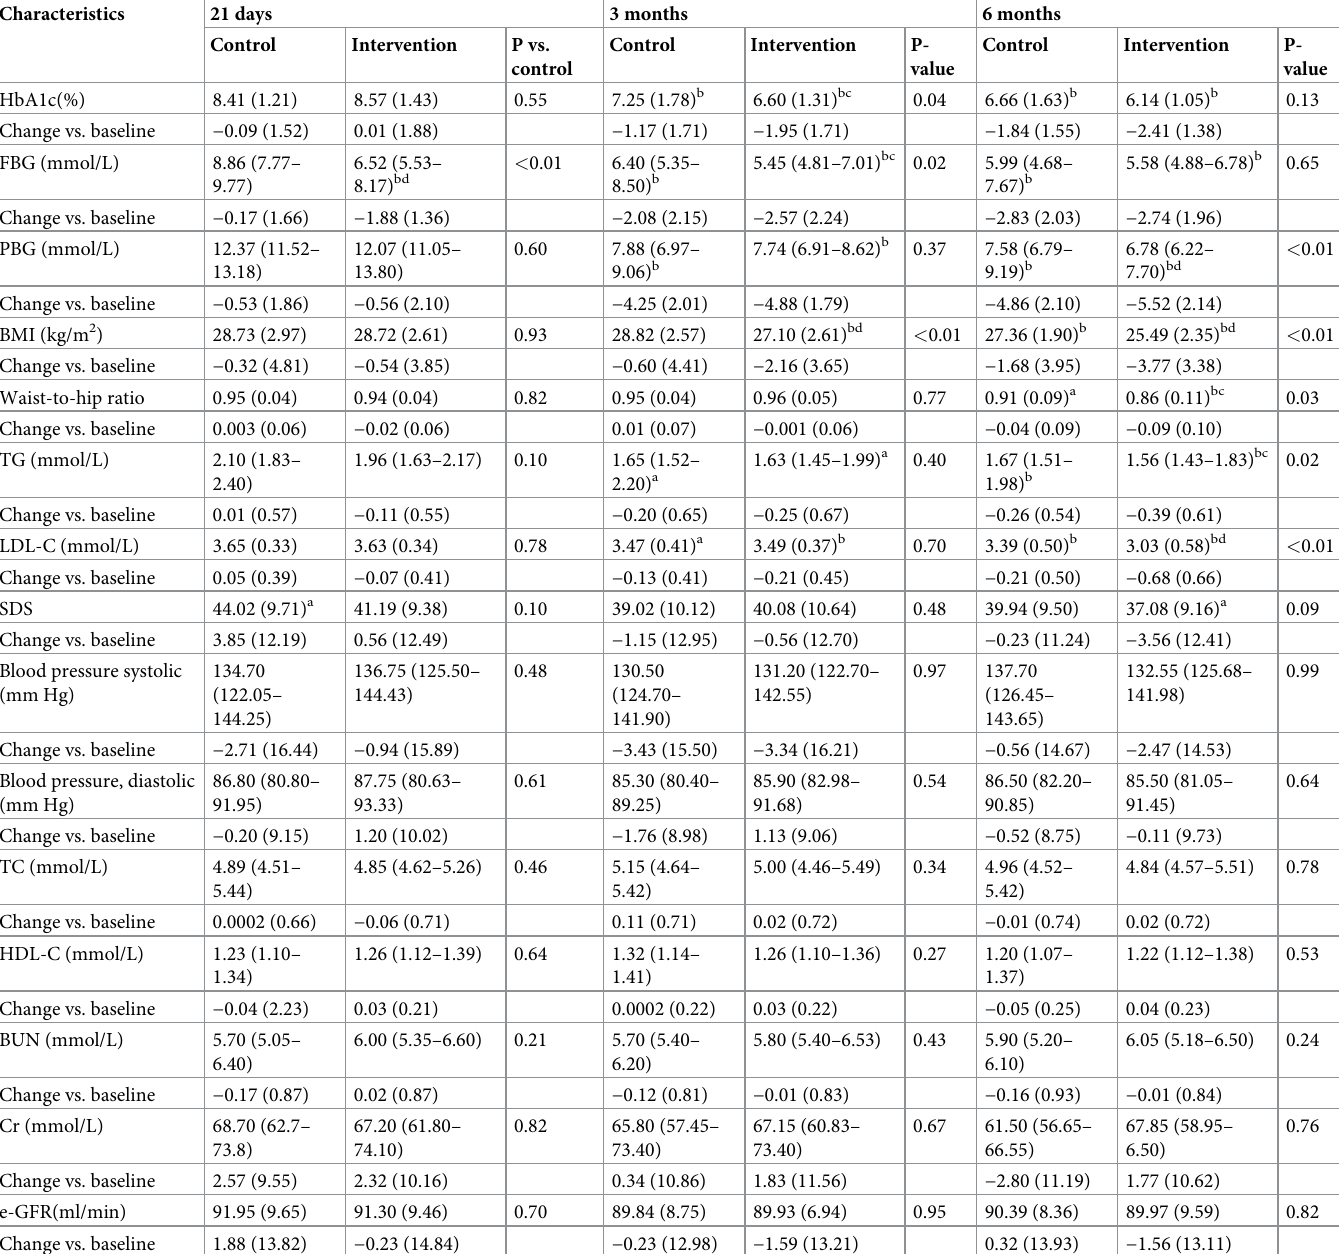
Table 2. The follow-up data of the two groups.